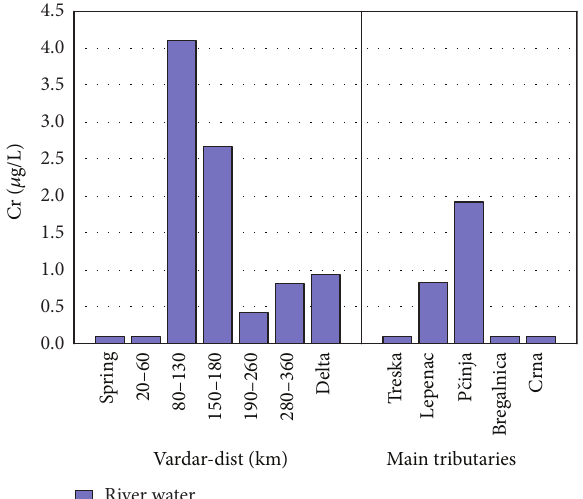
Figure 12: Concentration of Cr found in river Vardar and main